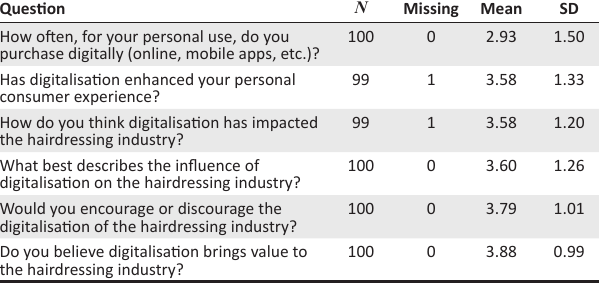
TABLE 4: Descriptive statistics of questionnaire ( n =